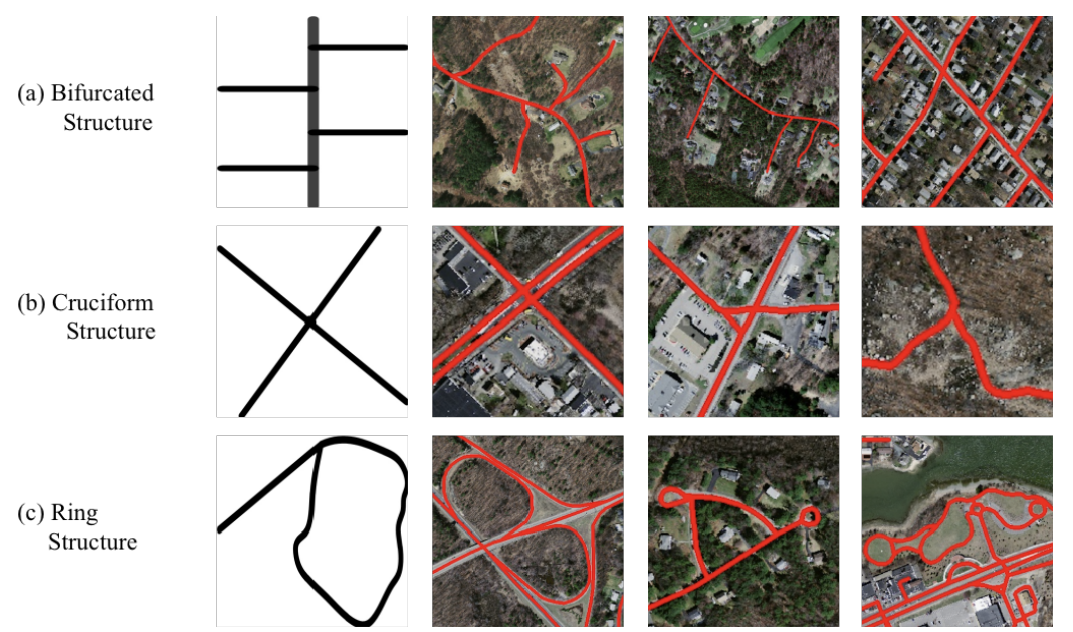
Figure 1. Samples of common topological structures of the road. ( a ) Bifurcated structure: often appears on city slip roads and country roads; ( b ) Cruciform structure: indicates crossroads; ( c ) Ring structure: often appears in parking lots and